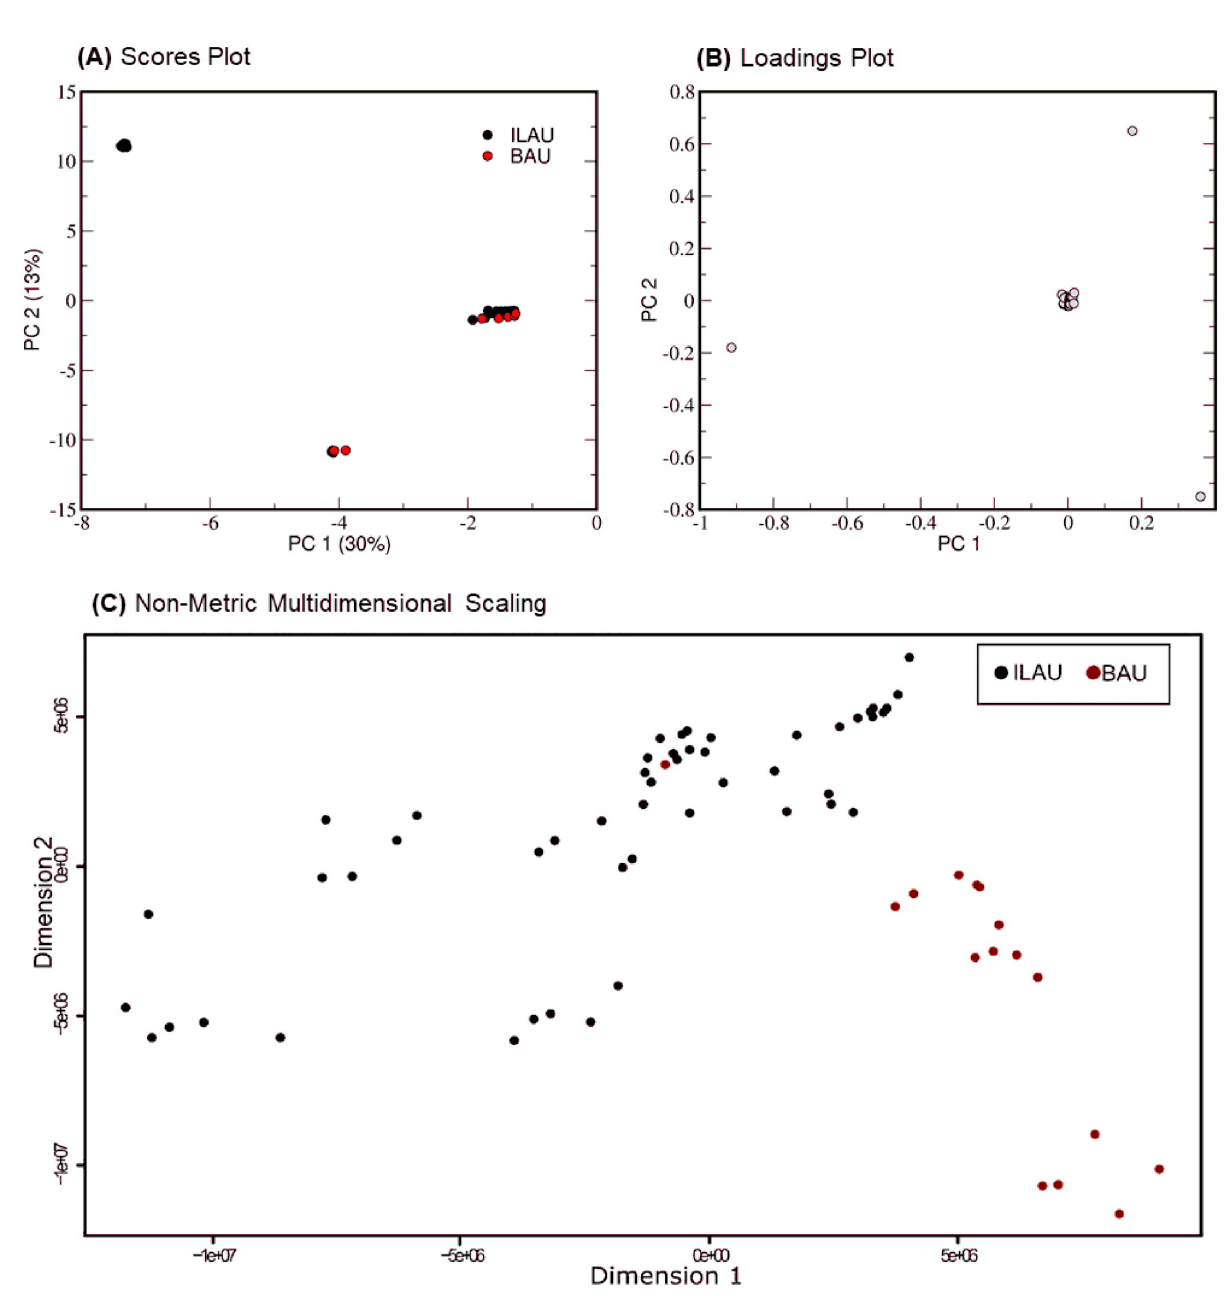
Fig 3. Comparison between authenticated garlic BAU and ILAU. Log-transformed PCA scores plot (A) shows that authenticated garlic BAU and ILAU clusters based on shared features.